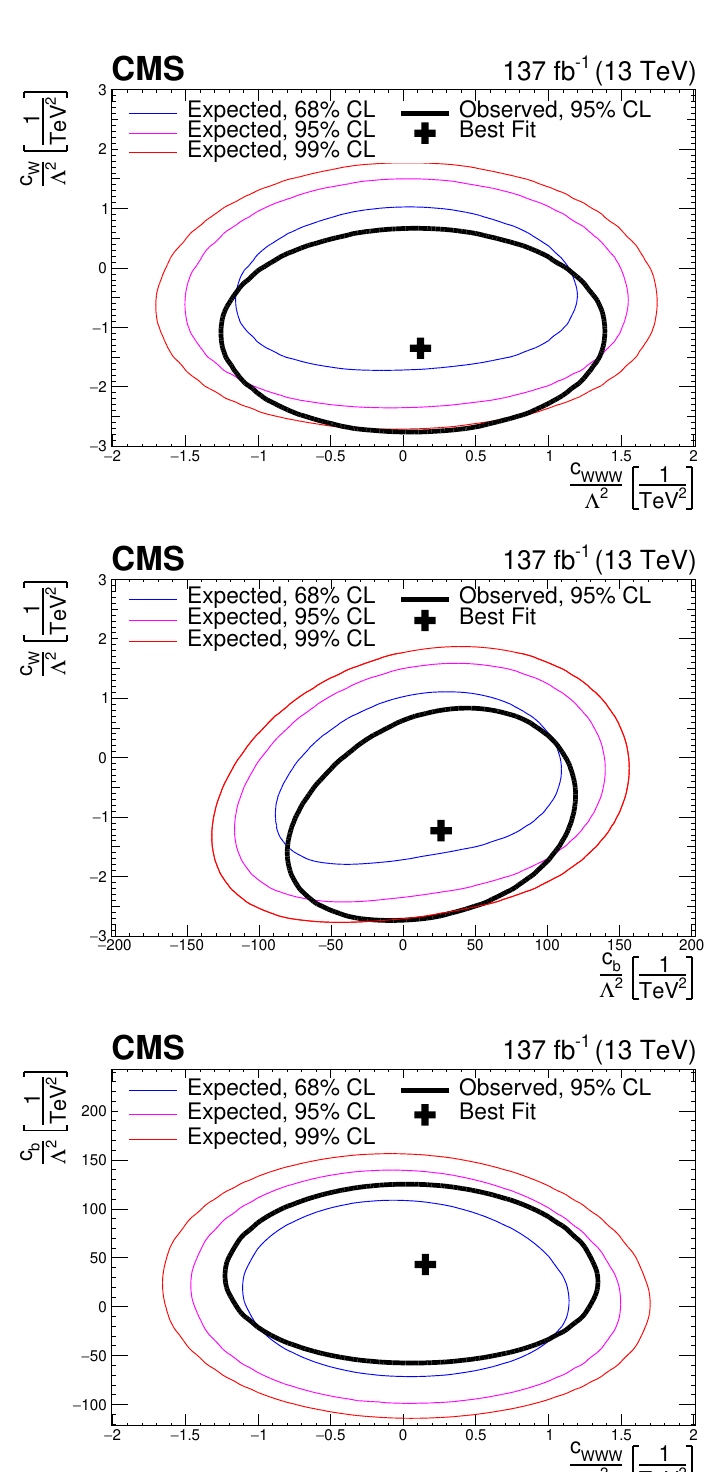
Figure 19 . Two-dimensional confidence regions for each of the possible combinations of the con- sidered CP-conserving EFT parameters: c c / Λ 2 vs. c / Λ 2 (bottom). The 68, 95, and 99% confidence level contours are presented in b www each